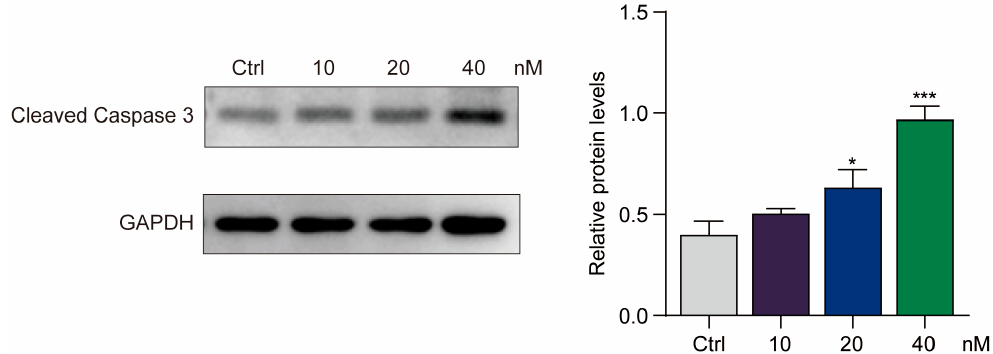
Figure 4. Effects of compound 8b on the expression of cleaved caspase 3. MHCC97H cells were incubated with compound 8b (10, 20 and 40 nM) for 24 h, followed by the Western blotting analysis of the expression of cleaved caspase 3. * p < 0.05, *** p < 0.001 vs. control. It is known that inhibitors that block c-Met activation are able to arrest the cell cycle at the G 1 phase [29]. Therefore, we performed a flow cytometric analysis to assess the cell-cycle distribution induced by compound 8b , using propidium iodide (PI) staining in MHCC97H cells. As shown in Figure 5, the proportions of cells at the G 1 phase in the presence of compound 8b were 79.4% at 10 nM, 83.9% at 20 nM and 86.2% at 40 nM, respectively. This gradual accumulation of MHCC97H cells at the G 1 phase with the increase in the concentration of compound 8b strongly suggests that this compound induced cell cycle arrest at the G 1 phase in MHCC97H cells.